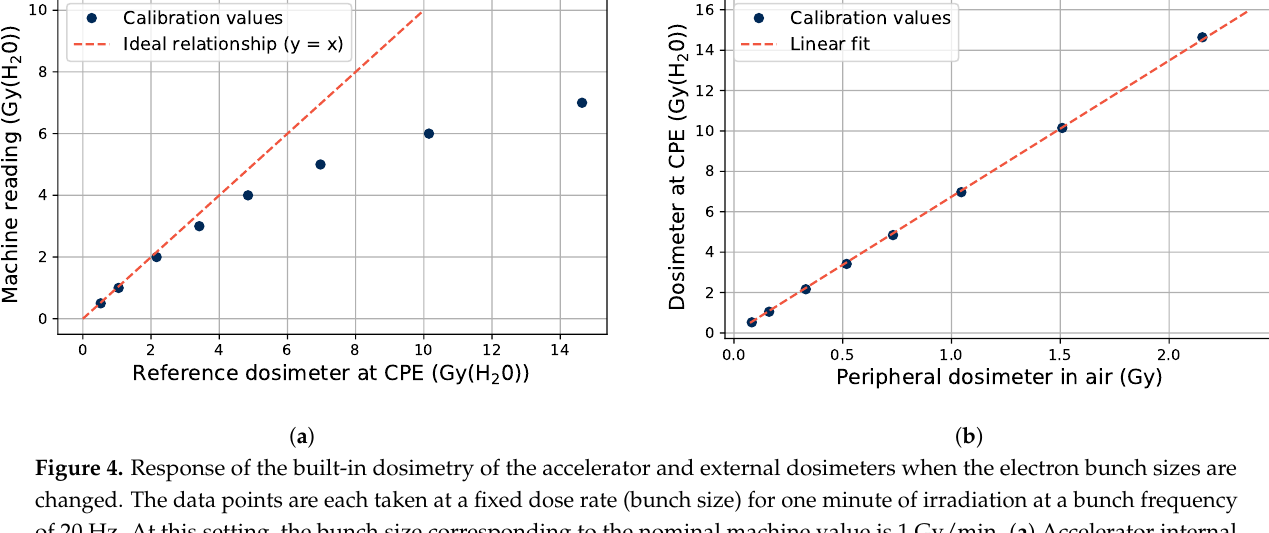
Figure 4. Response of the built-in dosimetry of the accelerator and external dosimeters when the electron bunch sizes are changed. The data points are each taken at a fixed dose rate (bunch size) for one minute of irradiation at a bunch frequency of 20 Hz. At this setting, the bunch size corresponding to the nominal machine value is 1 Gy/min. ( a ) Accelerator internal dosimetry against an external dosimeter at maximum dose depth in water. ( b ) Dosimeter at maximum dose depth in water against a peripheral dosimeter in